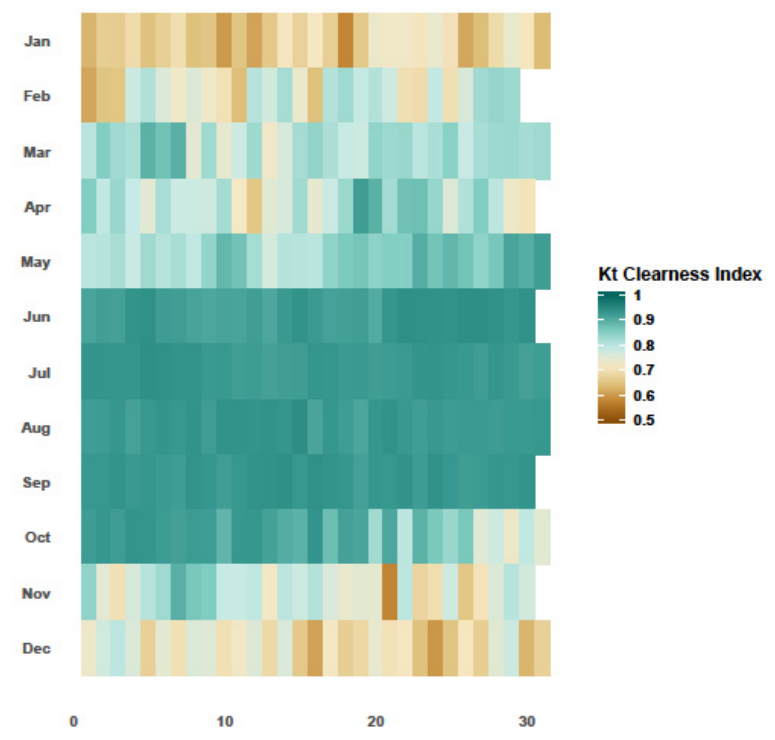
Figure 4. Mean Daily Clearness Indices ( K t ) by day and month for the period 2005–2017.